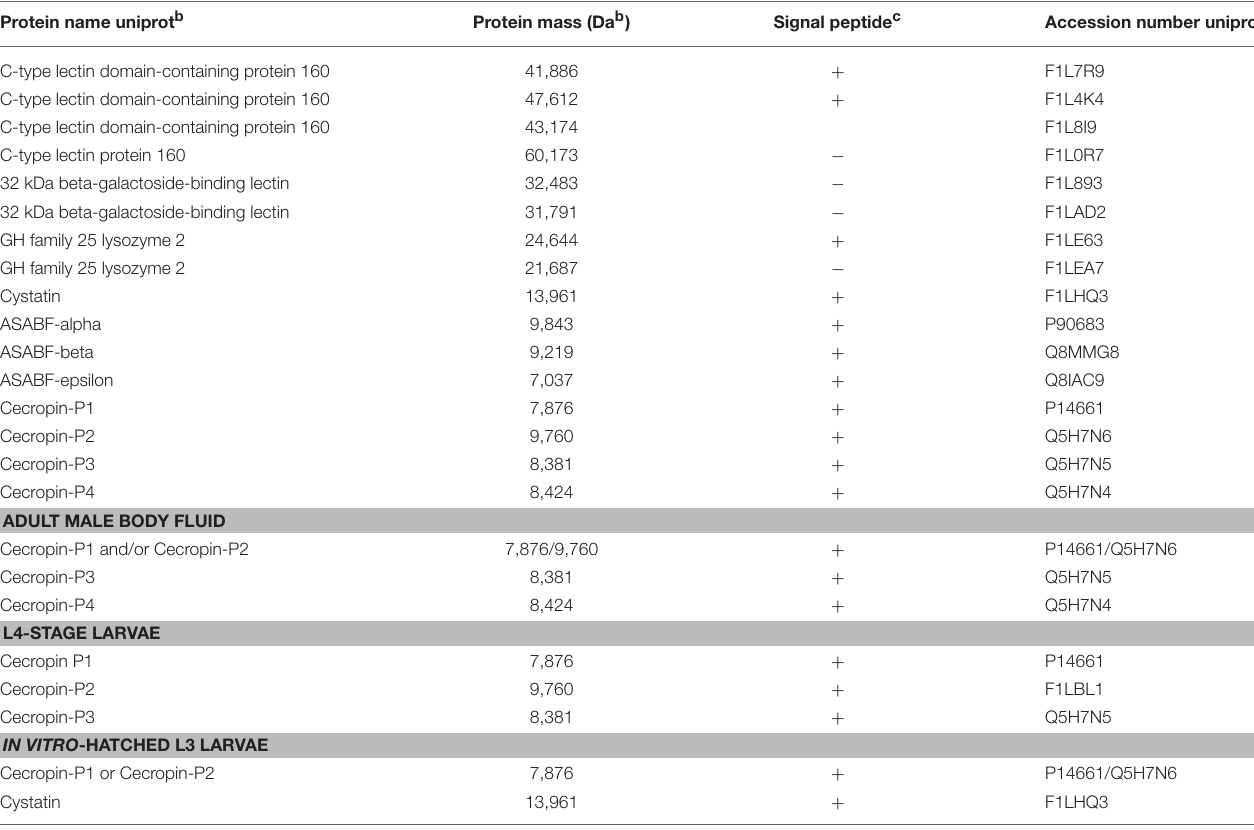
TABLE 1 | Proteins and peptides with known and predicted antimicrobial activities detected in excreted/secreted products and body fluid of A. suum a